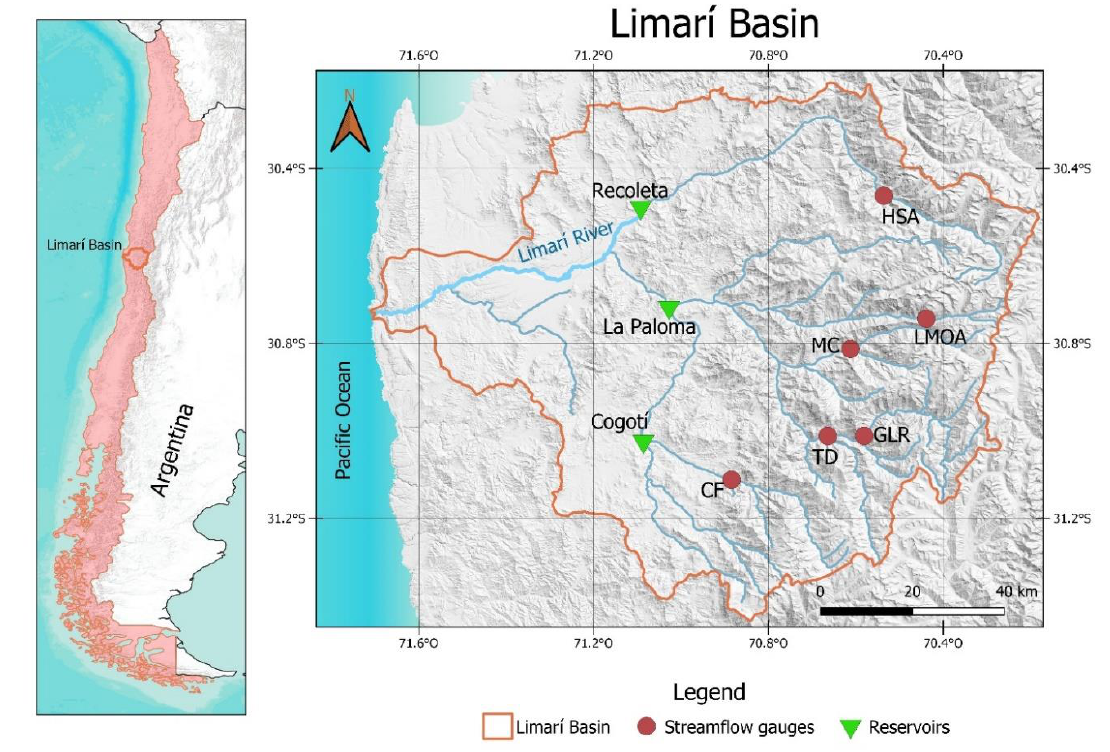
Figure 1. Map of the Limarí River basin and its location in Chile.